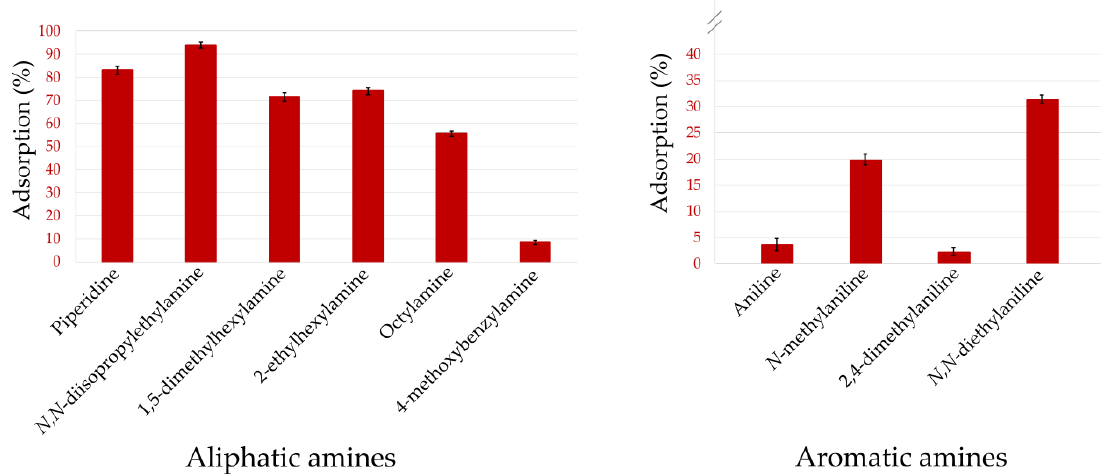
Figure 6. Graphical depiction of the adsorption performances of the composite with various aliphatic and aromatic amines.